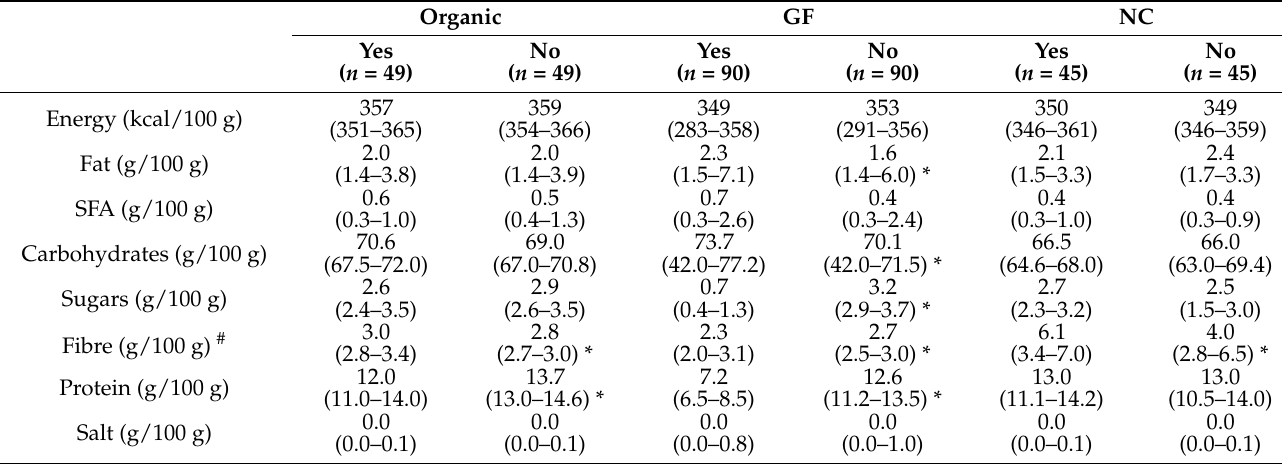
Table 2. Energy and nutrition facts in products with and without specific declarations, on selected pairs of products (as reported in Materials and Methods